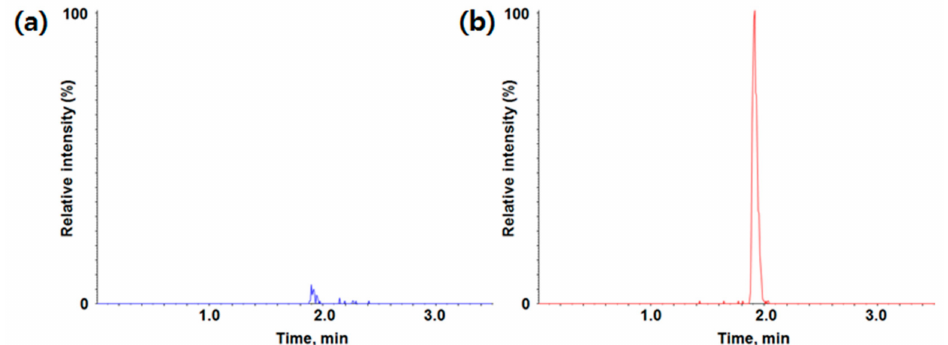
Figure 2. Typical chromatogram of ( a ) blank; ( b ) LLOQ (lower limit of quantification) for MMAF (monomethyl auristatin F) in rat plasma ( m / z 732.5 - > m / z